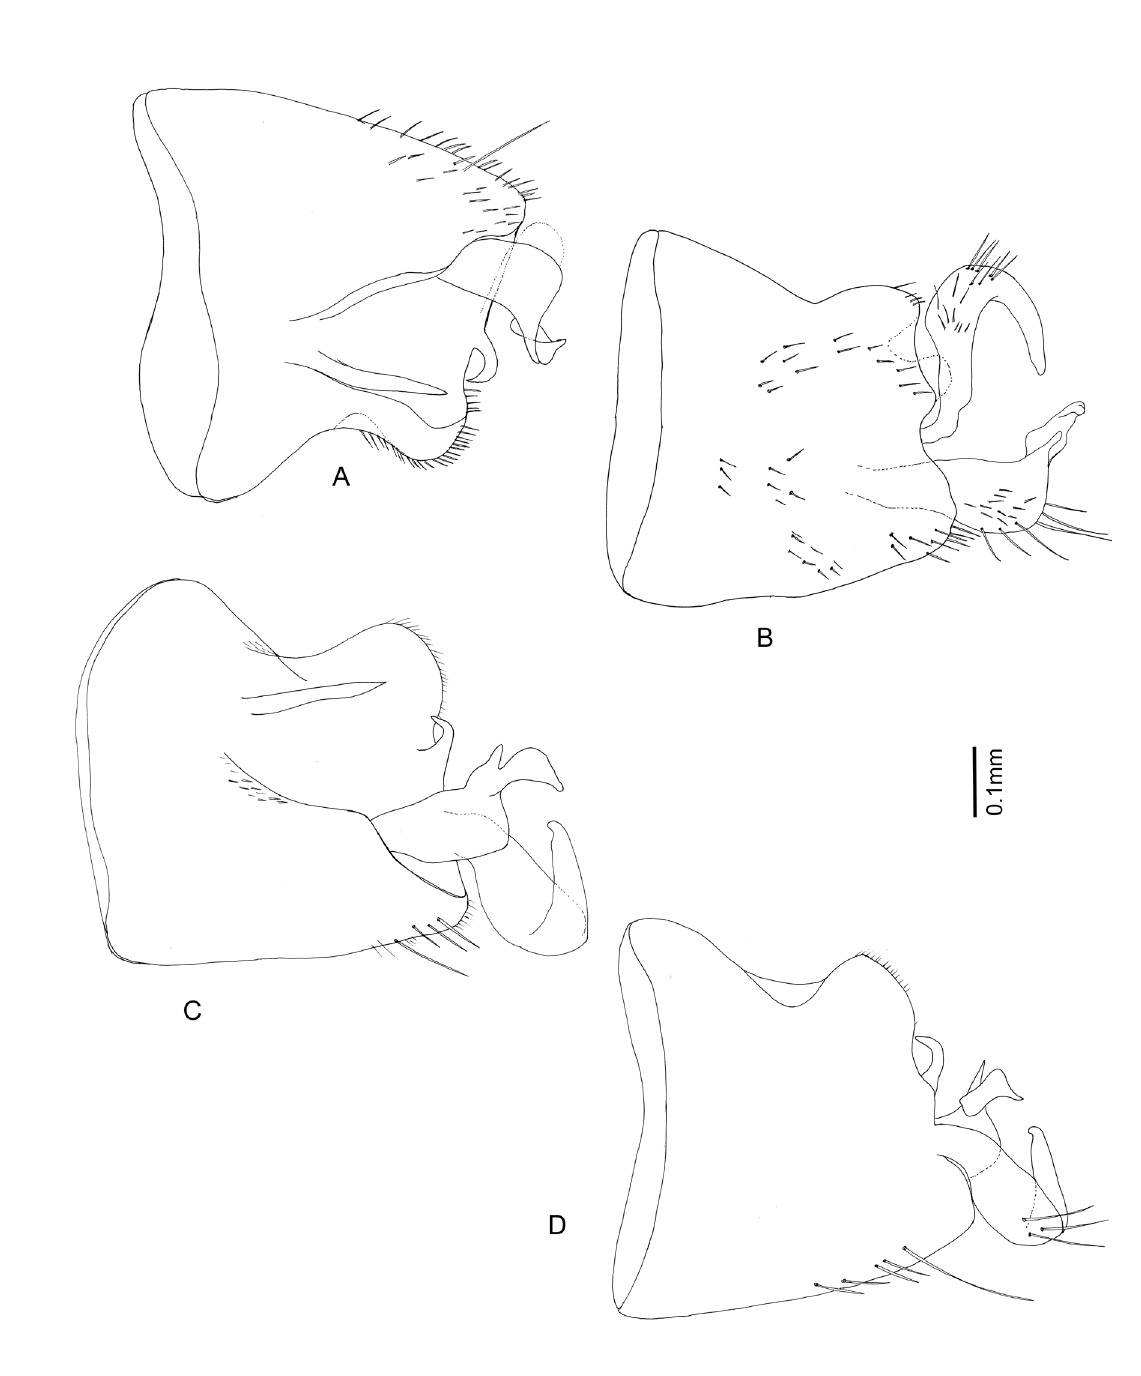
Fig. 23. Genital capsule of Stonedahlia mishmiensis gen. et sp. nov., ♂, paratype, UASB. A . Dorsal view. B . Ventral view. C . Left lateral view. D . Right lateral